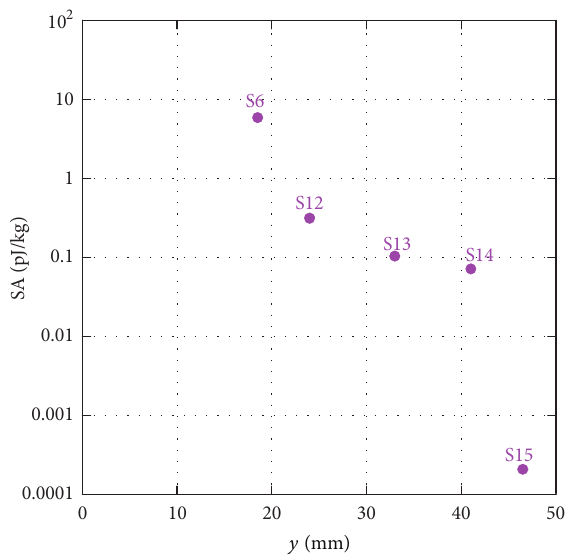
Figure 7: SA evaluated inside the head tissues as a function of the distance from the UWB